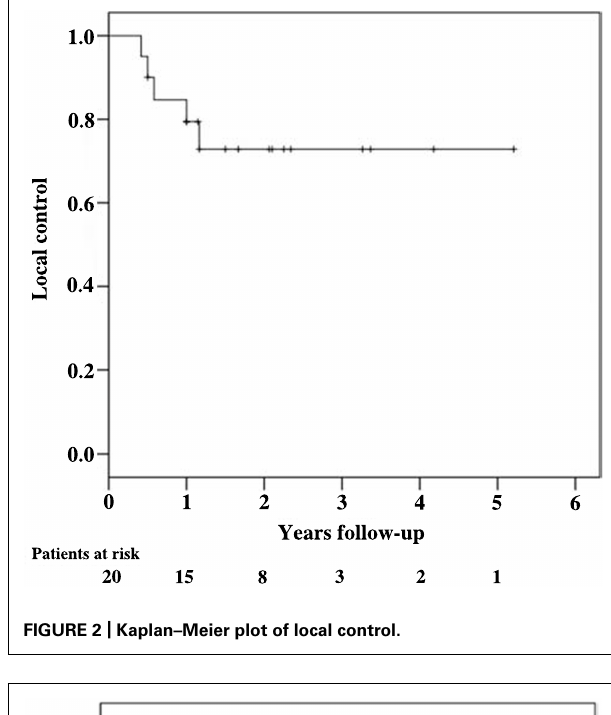
FIGURE 2 | Kaplan–Meier plot of local control.